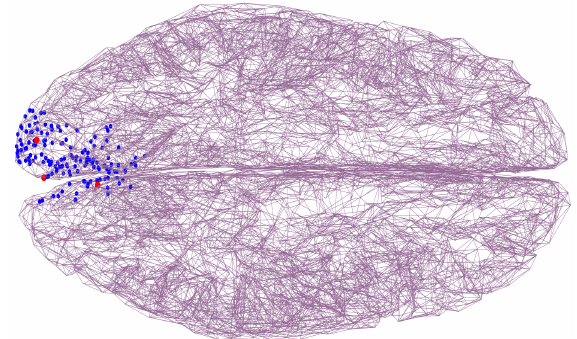
Figure 4. Tessellated model of the brain (top view). Red points indicate the L = 3 real sources’ positions. Other candidate positions that are part of the ROI are shown as blue points.